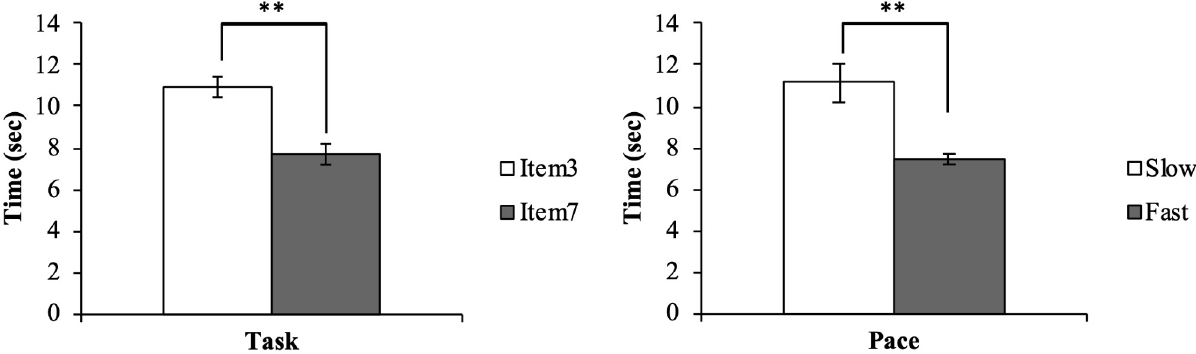
Experiment 2: Consistency with self-reported sleep time None of the participants removed the wristband-type PAT or withdrew from the experiment.